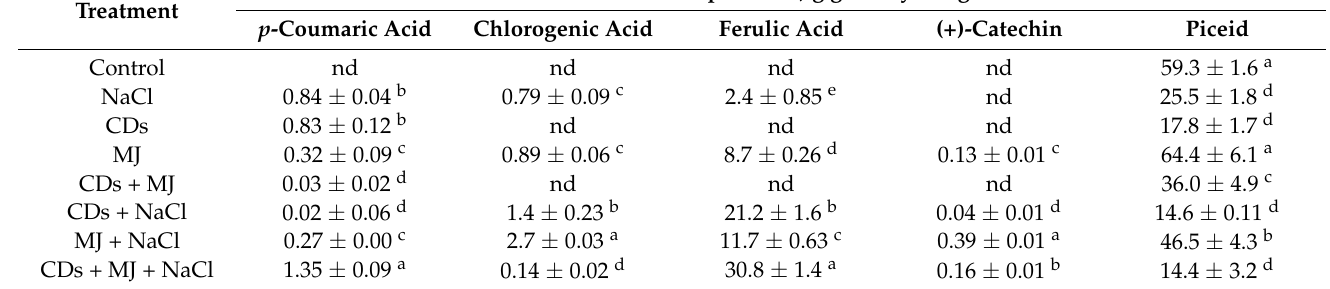
Table 1. The effects of salt and/or elicitor treatments on the intracellular accumulation of different phenolic compounds in Monastrell SCC. The data represent the mean ± SE of three independent replicates. Different letters in the same column indicate significant differences according to Tukey’s HSD test ( p ≤ 0.05). nd: